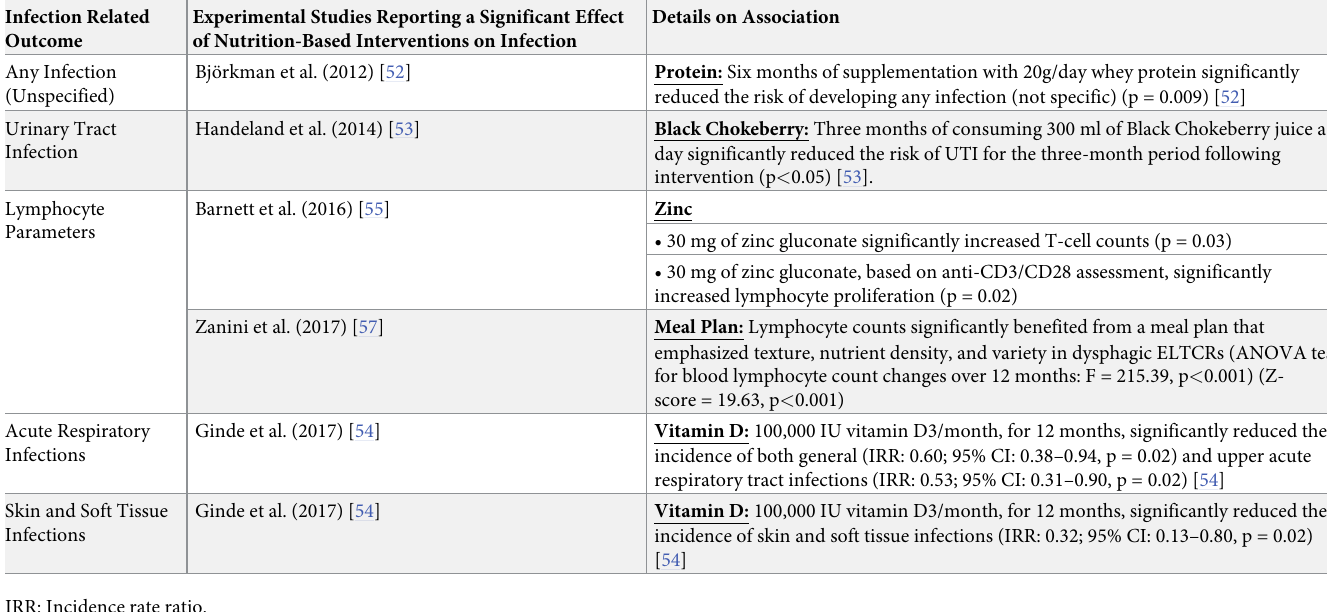
Table 2. Intervention studies reporting a significant association between nutrition & infection risk. Infection Related Experimental Studies Reporting a Significant Effect Outcome of Nutrition-Based Interventions on